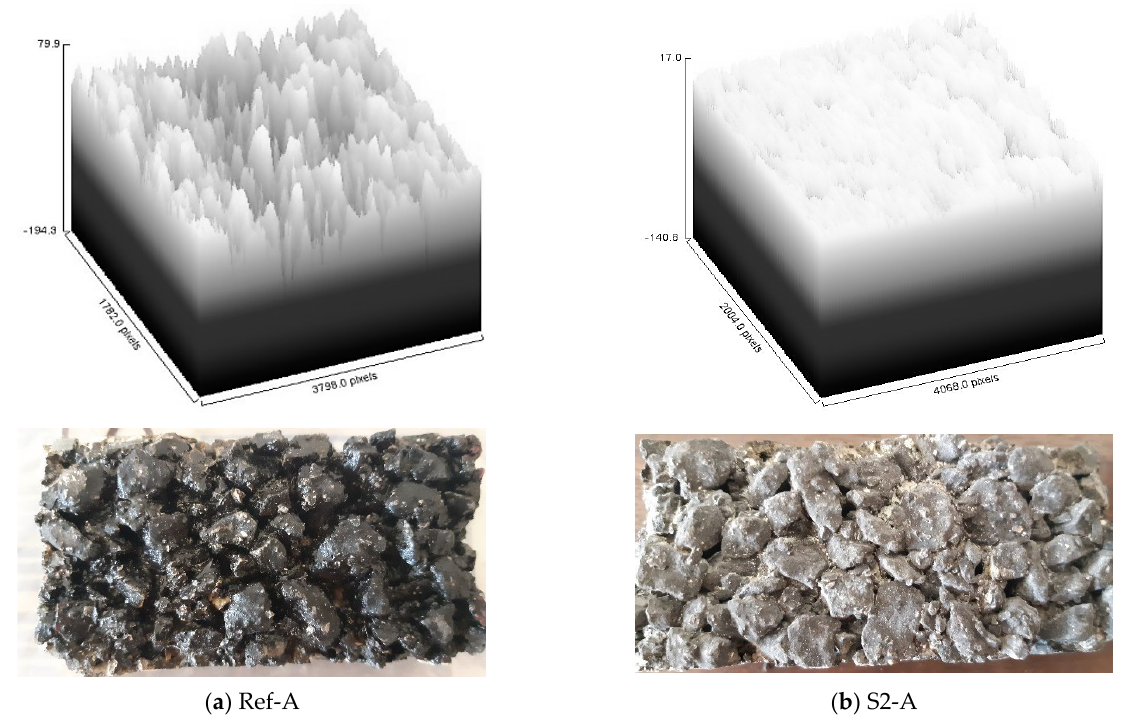
Figure 12. 3D roughness profiles and images for ( a ) reference asphalt (Ref-A) and ( b ) photocatalytic slab